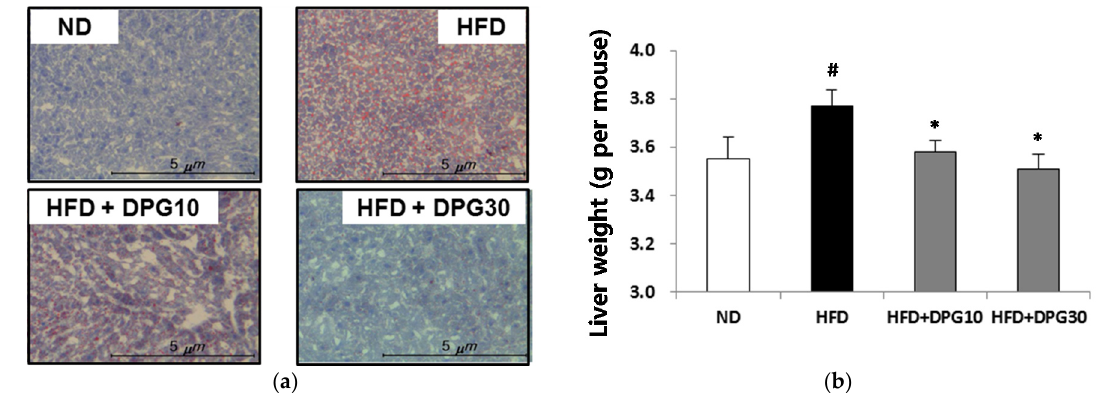
Figure 4. Effect of DPG10 and DPG30 on fat accumulation in liver and liver weight in HFD-induced obese mice. ( a ) Liver sections stained with Oil Red O; ( b ) liver weight per mouse. # p < 0.05 compared with ND group, * p < 0.05 compared with HFD group.